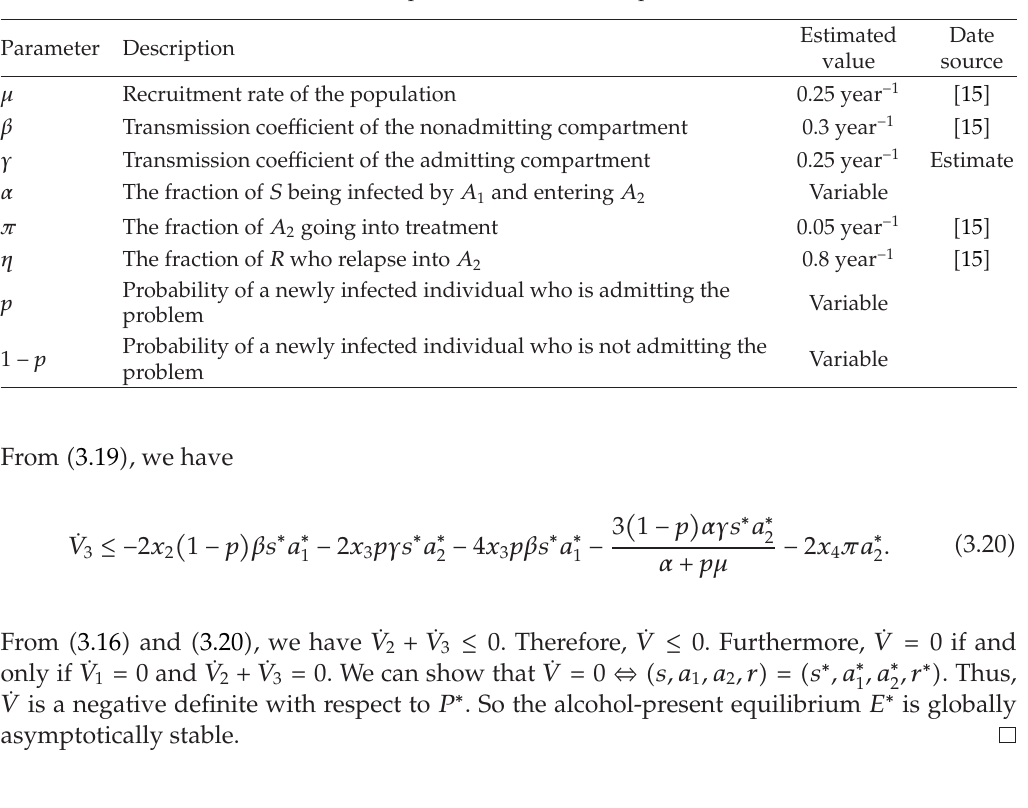
Table 1: Description and estimation of